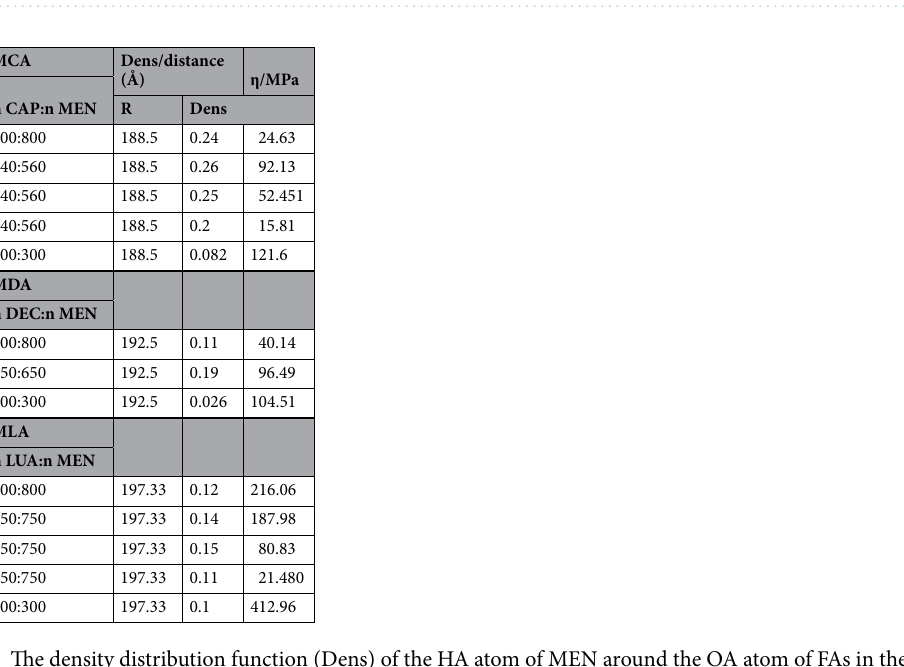
Figure 12. ( a ) Vector reorientation dynamics for bond vectors of MEN in the binary mixture of MCA with %CAP = 44 at 323 K, ( b ) Vector reorientation dynamics for bond vectors (HA–OA) of MEN in the binary mixture of MCA with %FAs = 70 at 323 K, ( c ) Vector reorientation dynamics for bond vectors (HA–OA) of MEN in the binary mixture of MLA with % LUA = 25 at different temperatures.